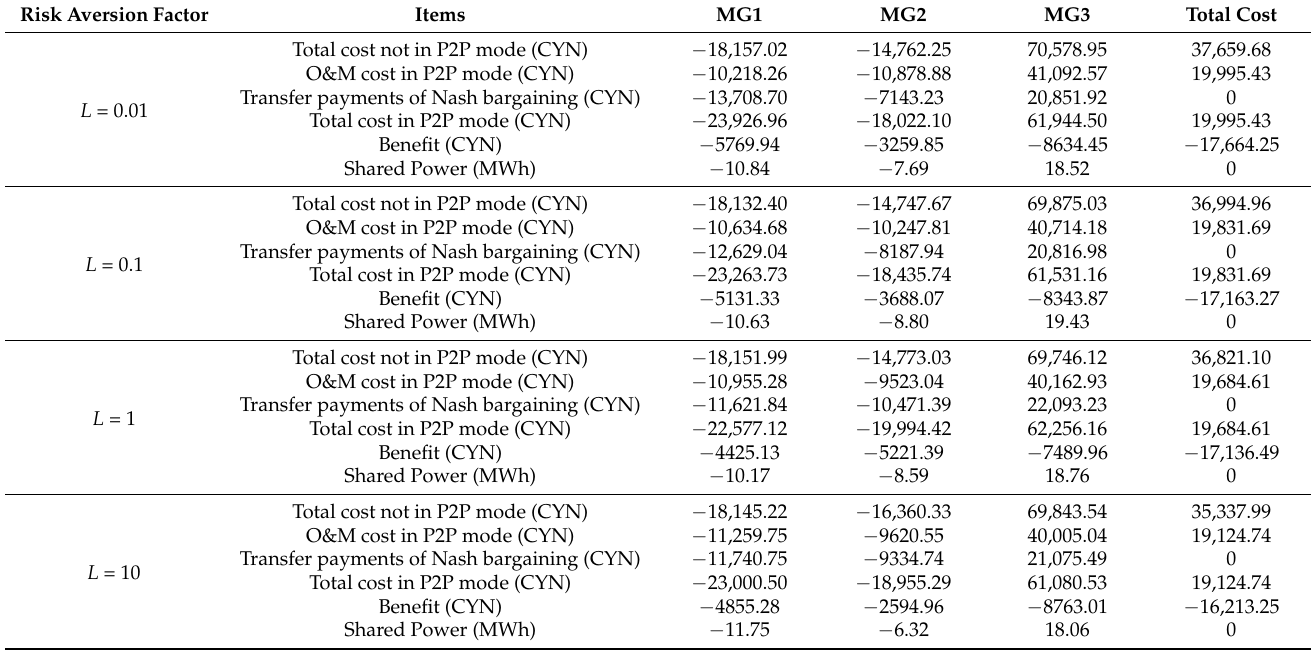
Table 4. Microgrid operating costs with different risk aversion factors (negative sign means